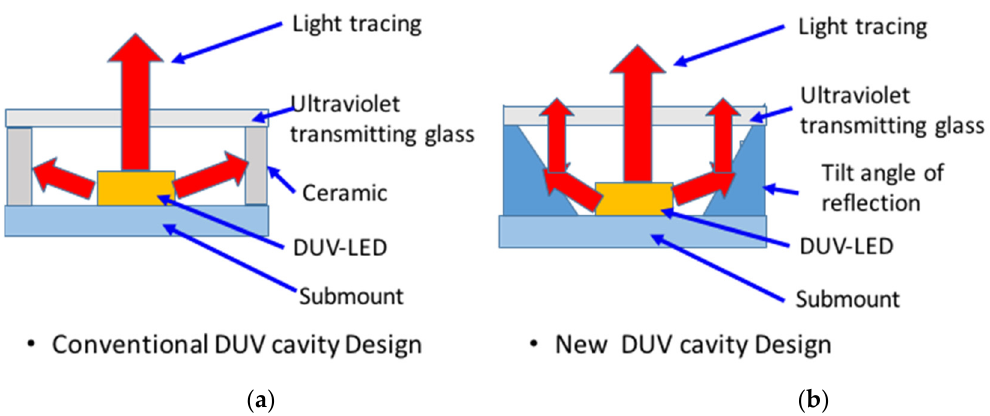
Figure 1. ( a ) Conventional deep-ultraviolet (DUV) cavity and ( b ) proposed metal tilt reflector design. LED: light-emitting diodes.